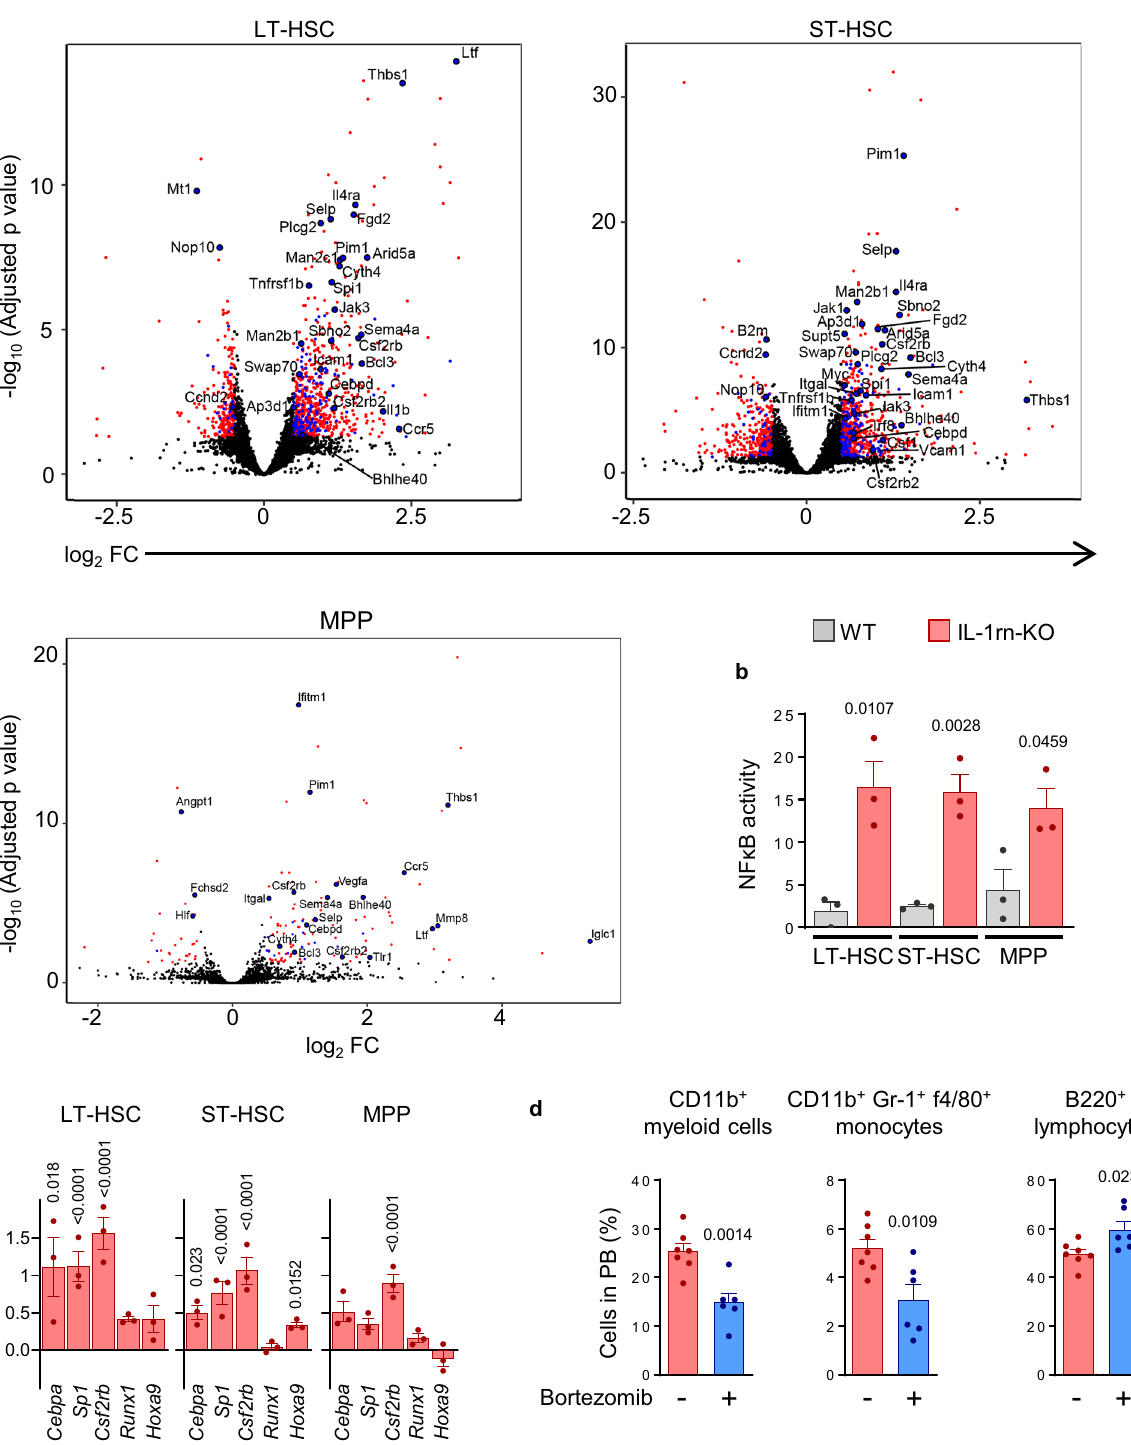
Fig. 3 | IL-1 β -induced myelopoiesis after IL-1rn deletion is mediated by NF κ B activation. a – c RNA sequencing in LSK CD34 − Flt3 − , long-term HSC (LT-HSC); LSK CD34 + Flt3 − , short-term HSC (ST-HSC) and LSK CD34 + Flt3 + MPP from IL-1rn knock- out (IL-1rn-KO) versus C57BL/6J wild-type (WT) mice ( n =3 per group). a Volcano plots show differentially expressed genes (red dots) and differentially expressed NF κ B target genes (blue dots) identi fi ed from Synapse ID syn4956655,